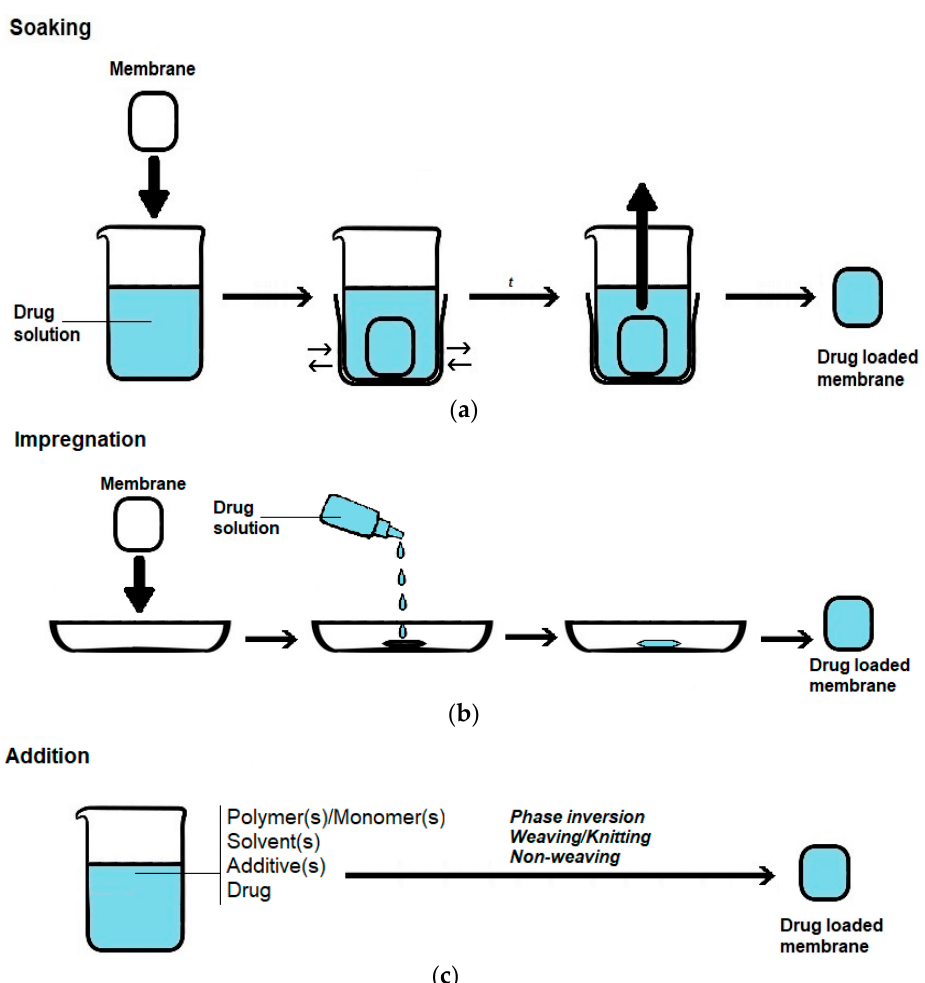
Figure 4. Schematic representation of the methods employed in loading a drug into a membrane. ( a ) Drug loading by soaking, in which the membrane to be loaded is immersed for a certain period in a drug solution, usually under agitation. It is the most straightforward method, but the loading yield can be low, as drug entry into the membrane occurs by diffusion across a concentration gradient. As such, some of the drug present in the solution will not be loaded. Loading yields depend not only on drug concentration, but also on other loading conditions (such as solvent, temperature, pH, ionic strength and time), as well as on drug/membrane interactions, molecular size of the drug, surface area, porosity and pore size of the membrane. ( b ) Drug loading by impregnation, in which the drug solution is added to the surface of the membrane to be loaded, being fully absorbed. ( c ) Drug loading by addition, in which the drug is added to the formulation employed to prepare the membrane. The drug must be able to withstand the conditions employed in membrane preparation and, usually, it has to dissolve in the formulation. With this method, non-toxic materials and reagents have to be employed, since extensive drug loss would occur if the final drug-loaded membrane was washed to extract cytotoxic leachables.